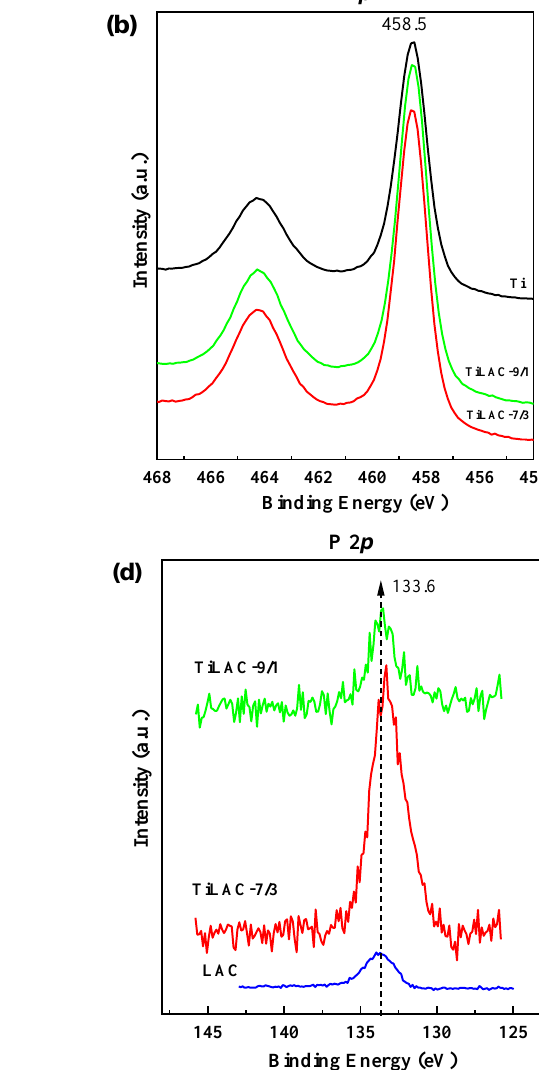
Figure 3. X-ray diffractograms of ( a ) LAC, ( b ) Ti, ( c ) TiLAC-7/3 and ( d ) TiLAC-9/1. XPS measurements were carried out to study the superficial chemical composition of the samples. Figure 4a shows C 1 s spectra for LAC and composite samples.